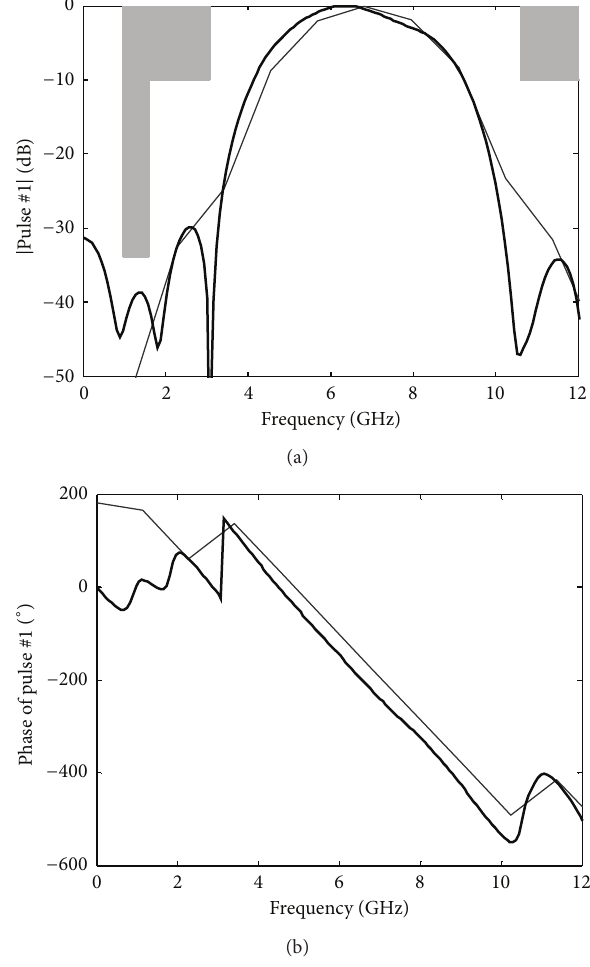
Figure13:Spectrum(a)magnitudeand(b)phaseofthetargetsignal (thin line) and Fourier-transformed measurement (thick line) of the pulse generated in the pulse shaper intended for UWB radar communications. The FCC UWB mask is also shown in